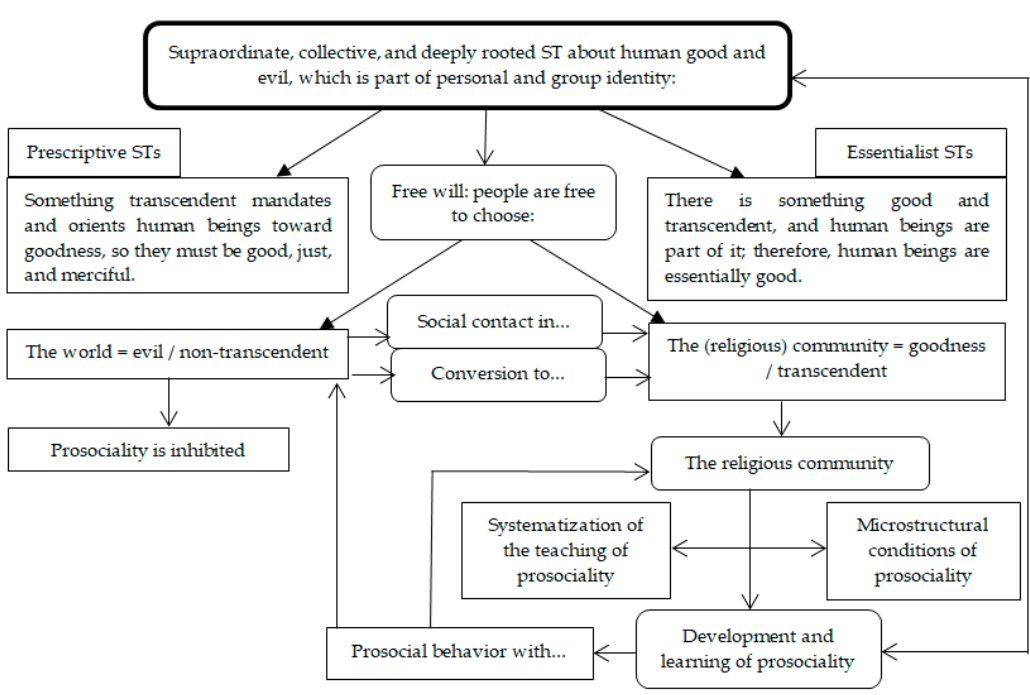
Figure 5. Selective coding: supraordinate STs about the development, teaching, and learning of prosociality.